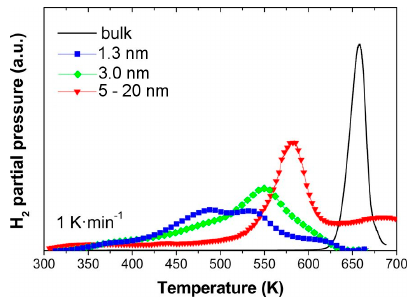
Figure 8. Thermal desorption spectra of MgH 2 NPs of different size confined/supported in a microporous carbon template compared to bulk Mg (black curve). The average size (diameter) of the NPs was obtained from the analysis of bright field electron micrographs. Adapted with permission from Ref. [56]. Copyright 2015 American Chemical Society.